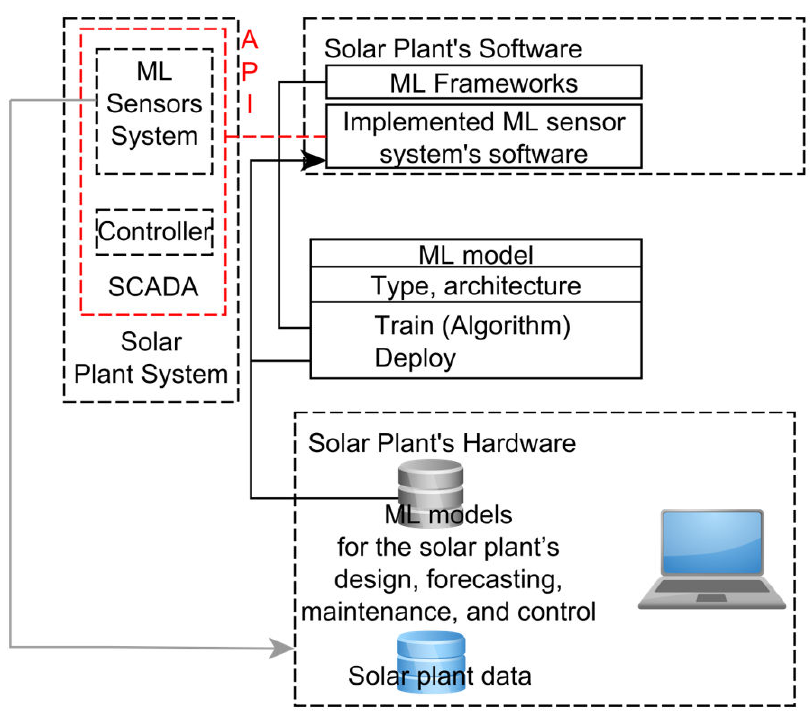
Figure 5. Solar plant system based on ML technologies.